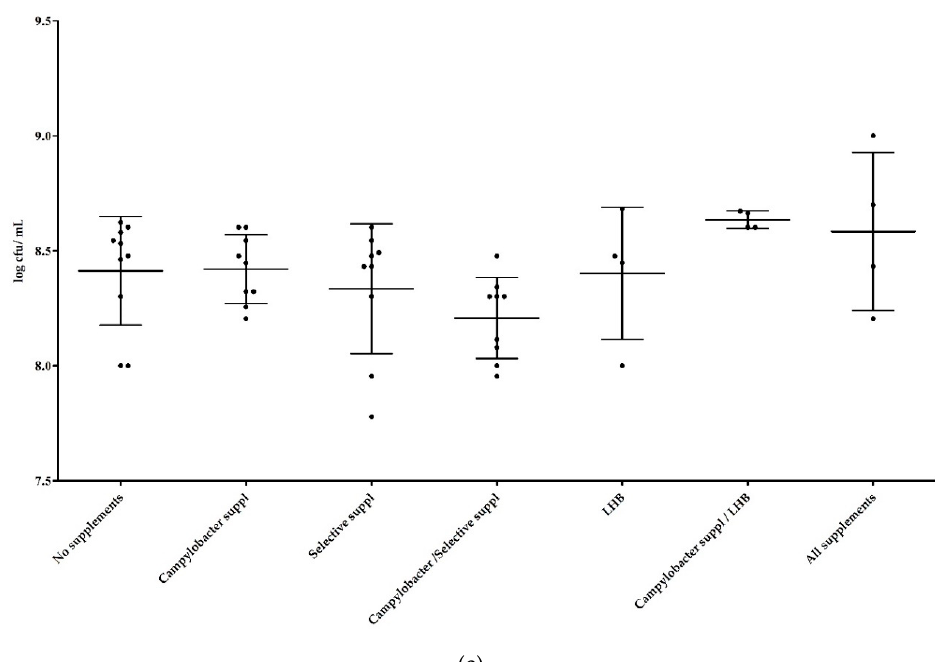
Figure 1. mTA10 medium optimization; ( a , b ) represent the growth kinetics at 30 °C and 35 °C